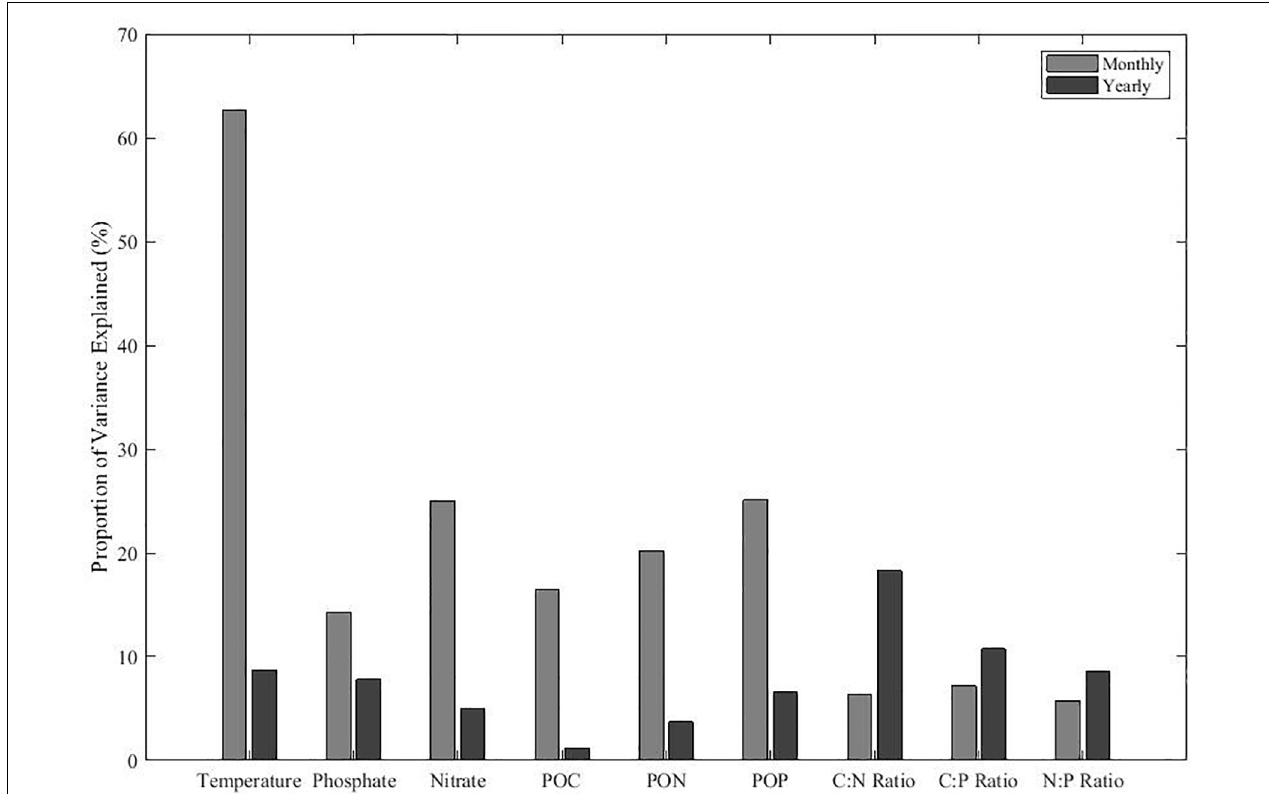
FIGURE 4 | The contribution of monthly and annual variation for environmental conditions and POM concentrations and ratios. The remaining variance represents variance associated with short-term events and measurement errors. Proportions are calculated using the sum of squares from the linear regression data shown in Figure 5